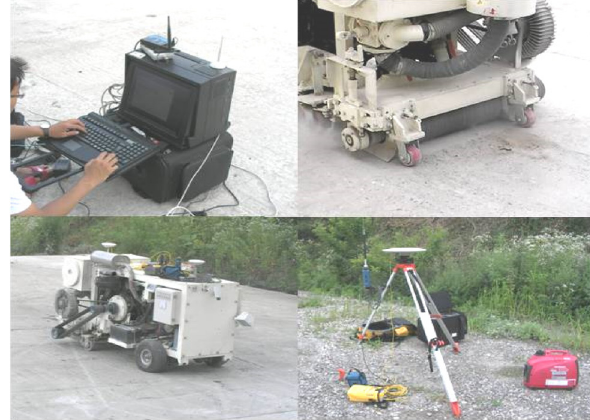
Fig. 8. Prototype performance